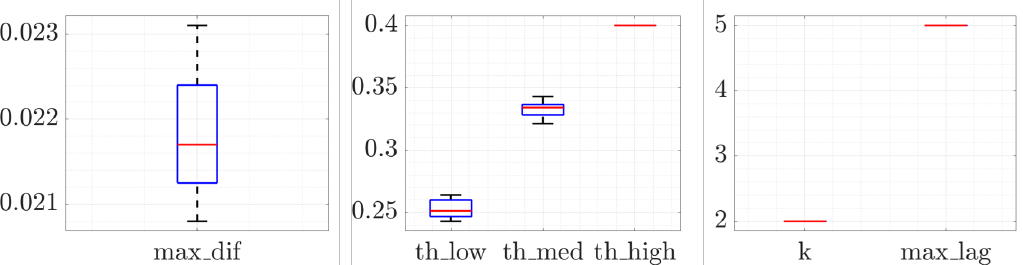
Figure 3. Optimal configuration of the parameters of the online block for each of the twenty training datasets of the k-fold cross-validation